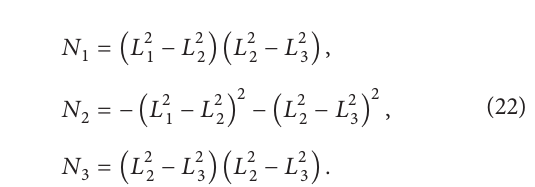
Figure3:Outputworkspaceofthewaterwaveenergyharvesterwith 𝐿 = 1 m and 𝐷 = 0.1 m.